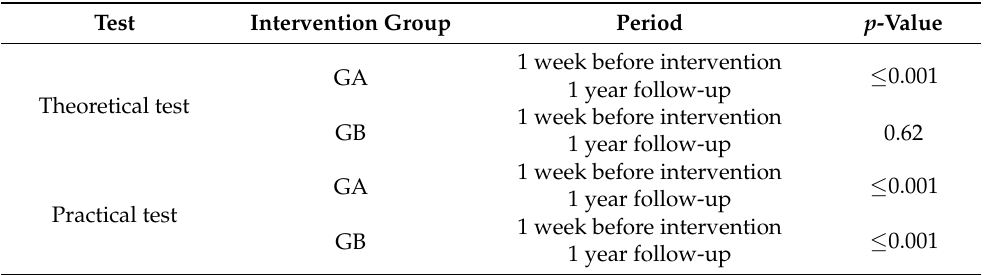
Table 2. Comparison between the periods of the evaluations (before and after intervention).